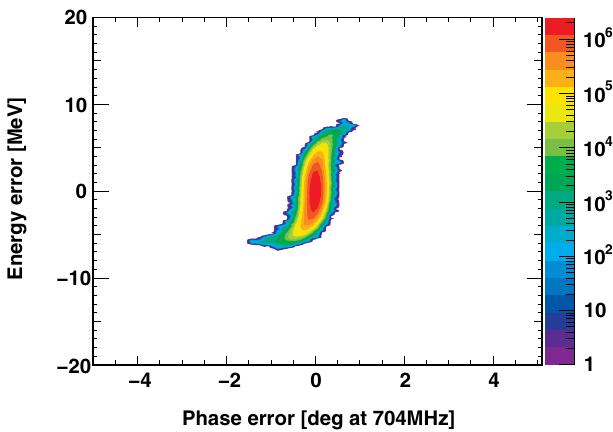
FIG. 5. 2D phase space histogram at the exit of 1000 linacs, where always the same pulse was tracked through, but the seed for the HOM frequency distribution was varied. Settings: N ¼ 1000 , see Table VI.